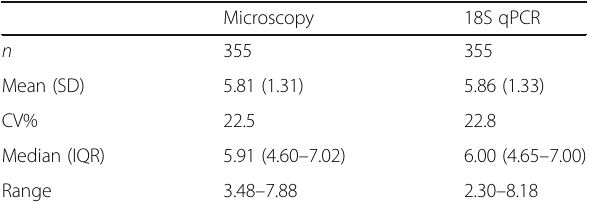
Table 1 Comparison of log 10 parasitemia values/mL